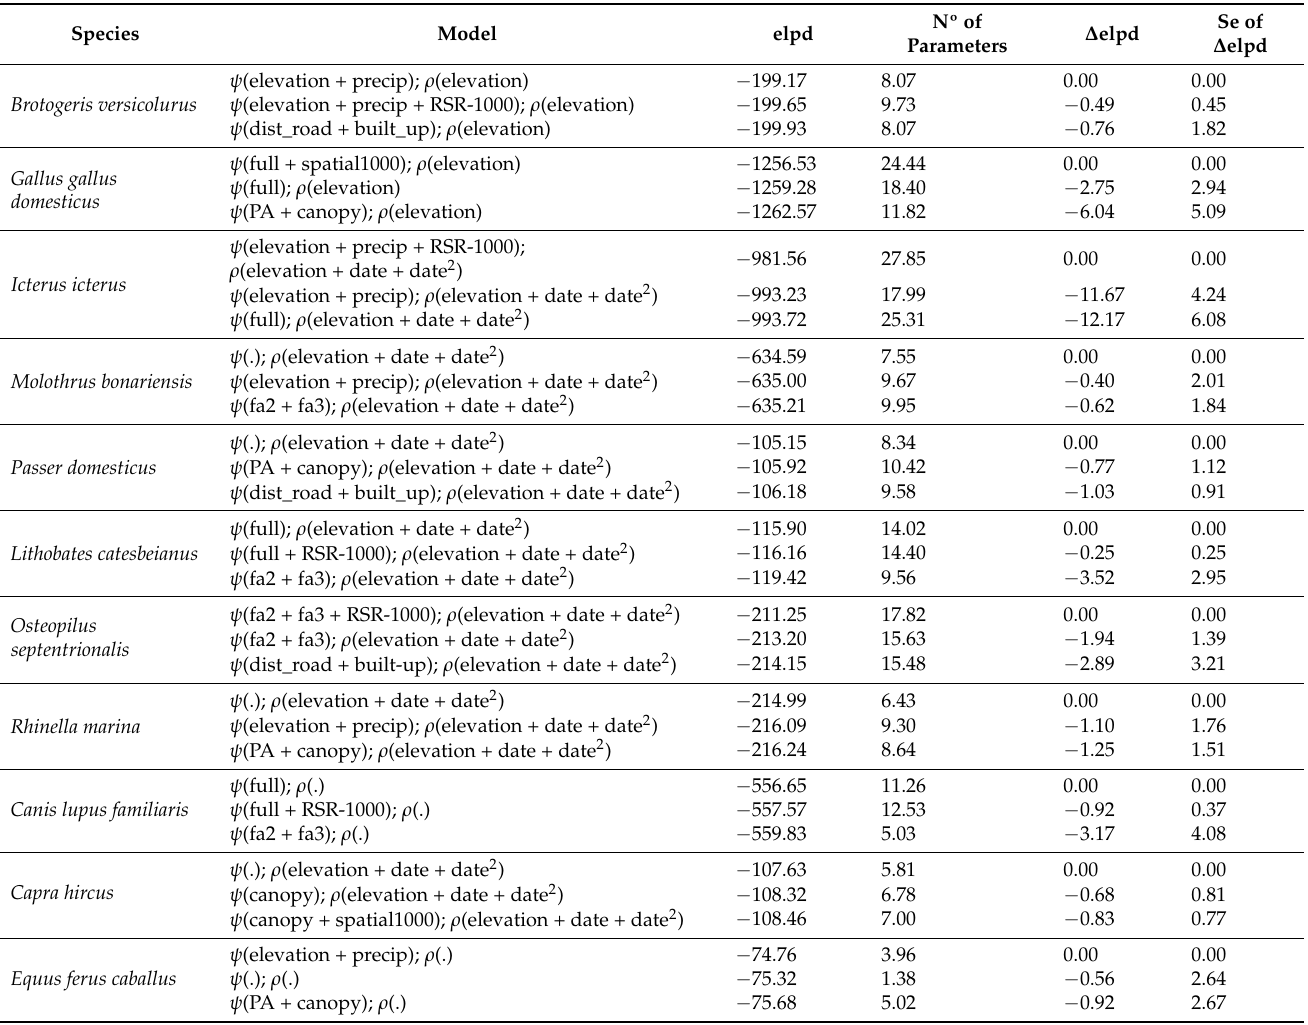
Table 2. Three top-ranked models for eleven alien invasive species in Puerto Rico. ELPD = expected log pointwise predictive density; ∆ ELPD = difference of ELPD relative to the top-ranked model; se of ∆ elpd = standard error of elpd; RSR = restricted spatial regression (threshold = 1000 m); PA = proportion of protected area; fa2 = proportion of forest cover aged between 32 and 54 years; fa3 = proportion of forest cover aged older than 54 years; dist_road = distance from roads (m); built_up = built-up proportion; date = Julian date (we considered Julian day 1 as the first day of a device starting to record in the field, which was 1 March 2021); date 2 = square of Julian